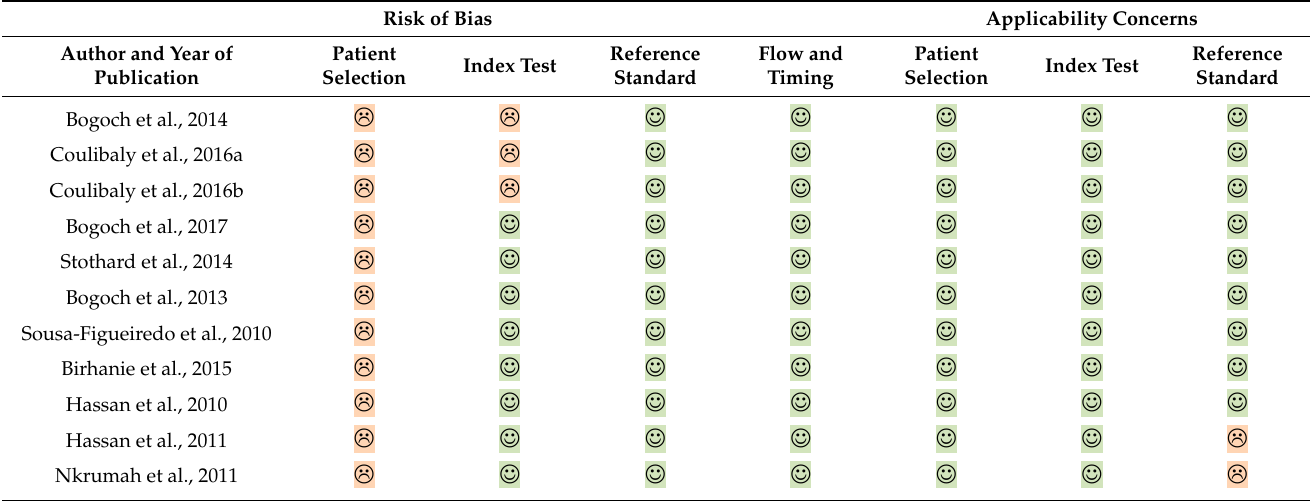
Table 3. Summary of methodological quality assessed with the QUADAS-2.